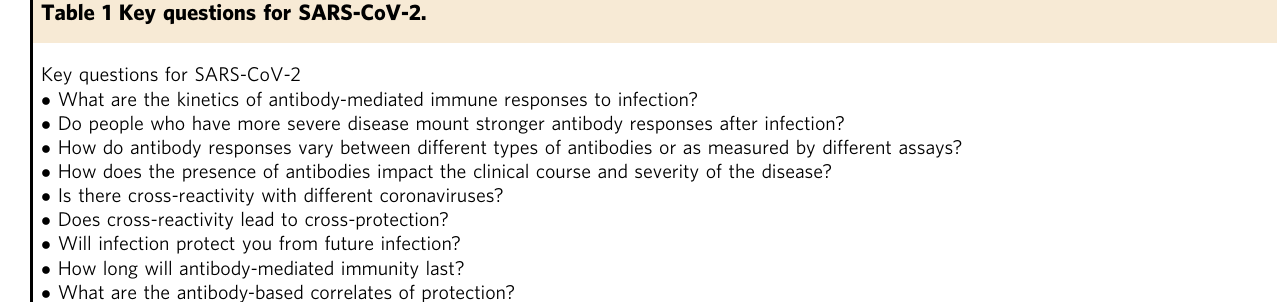
Table 1 Key questions for